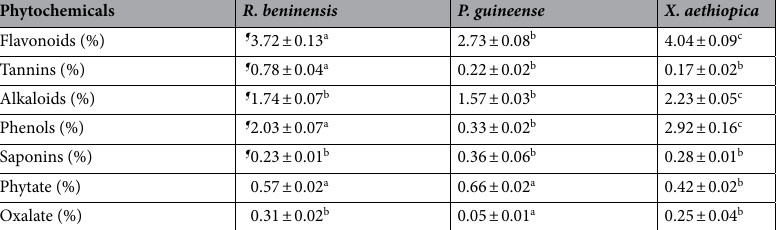
Table 2. Phytochemical constituents of selected spices. Values are expressed as mean ± standard error of mean ( X ± S.E.M.) in triplicate. Values with different letters along the same row are significantly different ( p < 0.05). ¶ Values derived from our previous published work 6